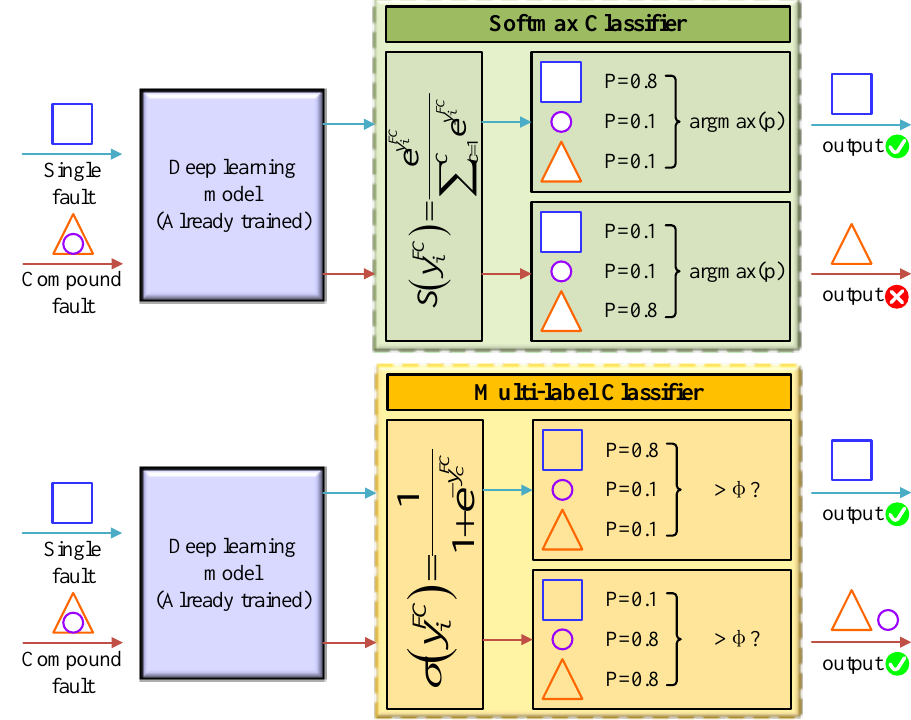
Figure 1. SoftMax classifier and multilabel classifier.